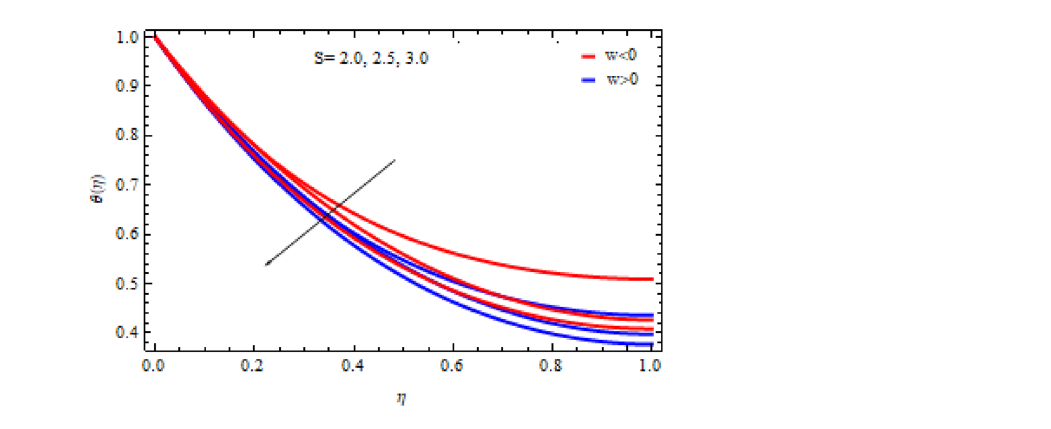
Figure 5. Temperature field by